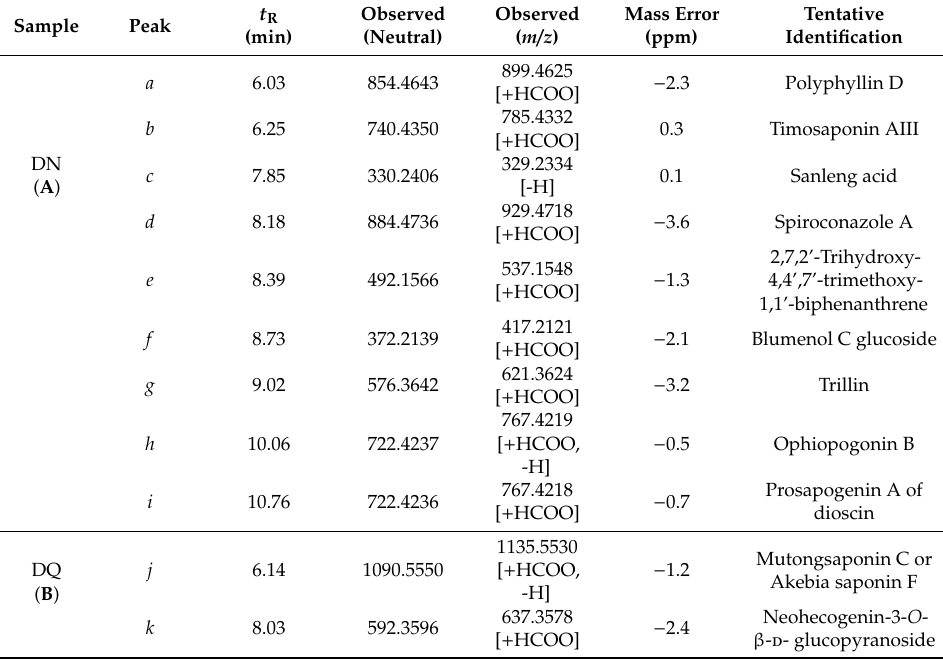
Table 5. Estimates of unidentified peaks based on the MS / MS database